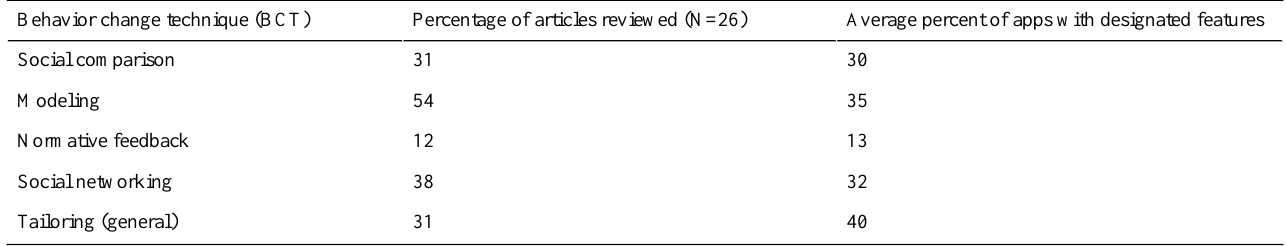
Table 3. Percentages of articles reviewed (26 articles) that included each behavior change technique (BCT) category, and average percentages of apps identified by these articles as including features that belong to each BCT category.